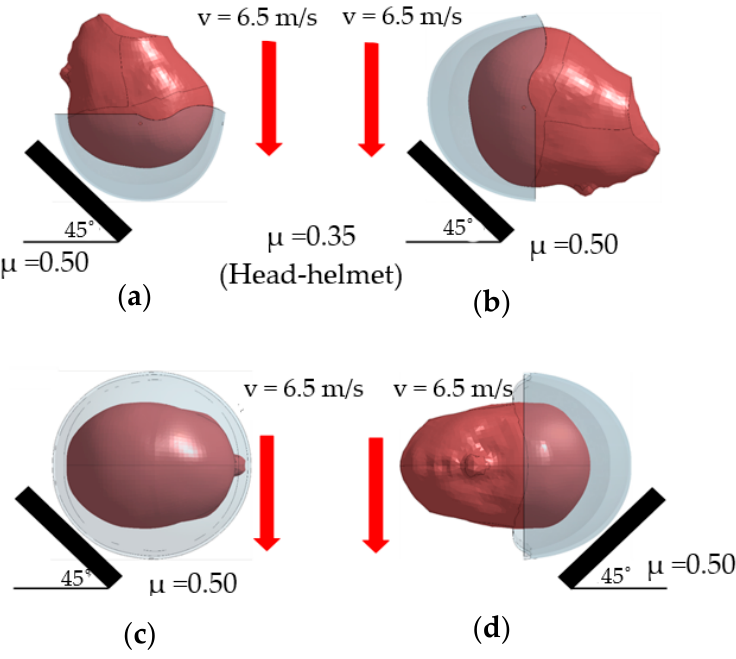
◦ inclined drop test at ( a ) crown, ( b ) front, ( c ) rear, and ( d ) Figure 4. Model setup for the 45° inclined drop test at ( a ) crown, ( b ) front, ( c ) rear, and ( d ) side. Figure 4. Model setup for the 45